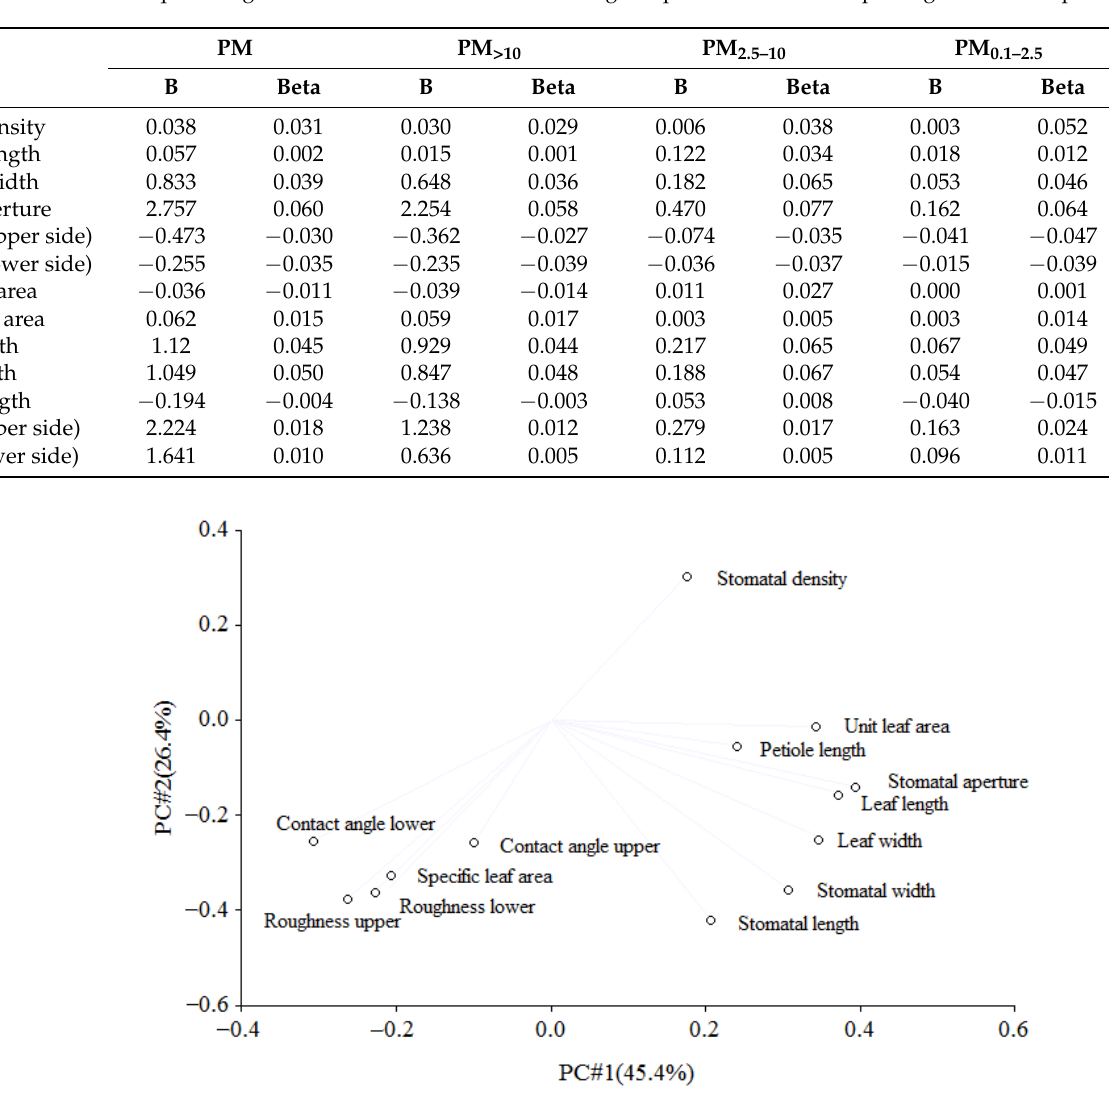
Figure 3. Loading plot of principal component analysis of the tree species with 13 dependent varia- bles. Table 3. Regression coefficient (B) and standardized regression coefficient (Beta) of the partial least squares regression model for the factors affecting leaf particulate matter capturing of four tree spe- cies.